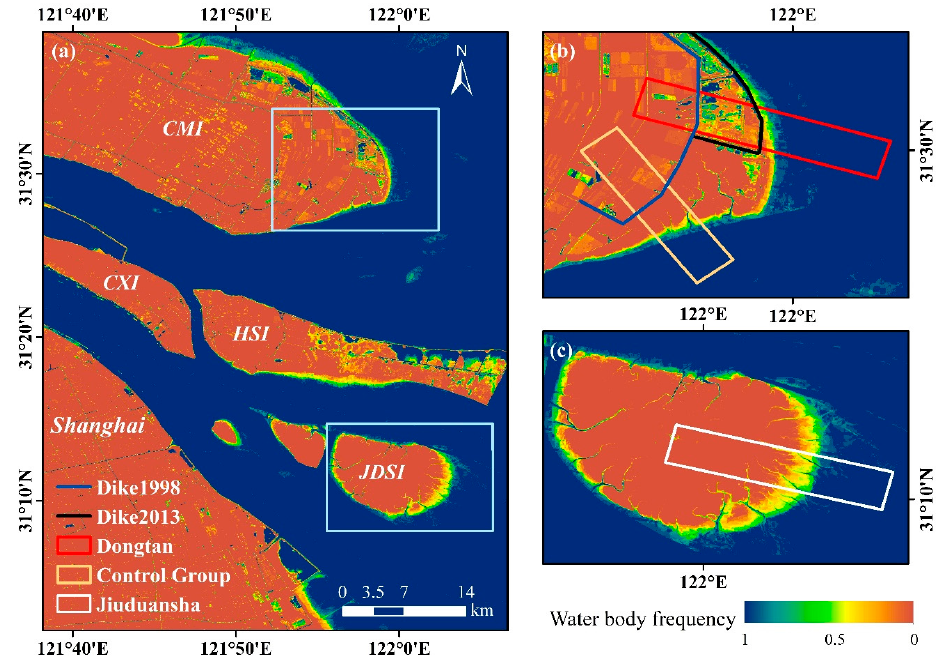
Figure 2. Locations of sample areas: ( a ) light blue boxes are locations of ( b , c ); ( b ) red box is Dongtan (DT) and orange box is control group (CG); ( c ) white box is Jiuduansha (JDS).